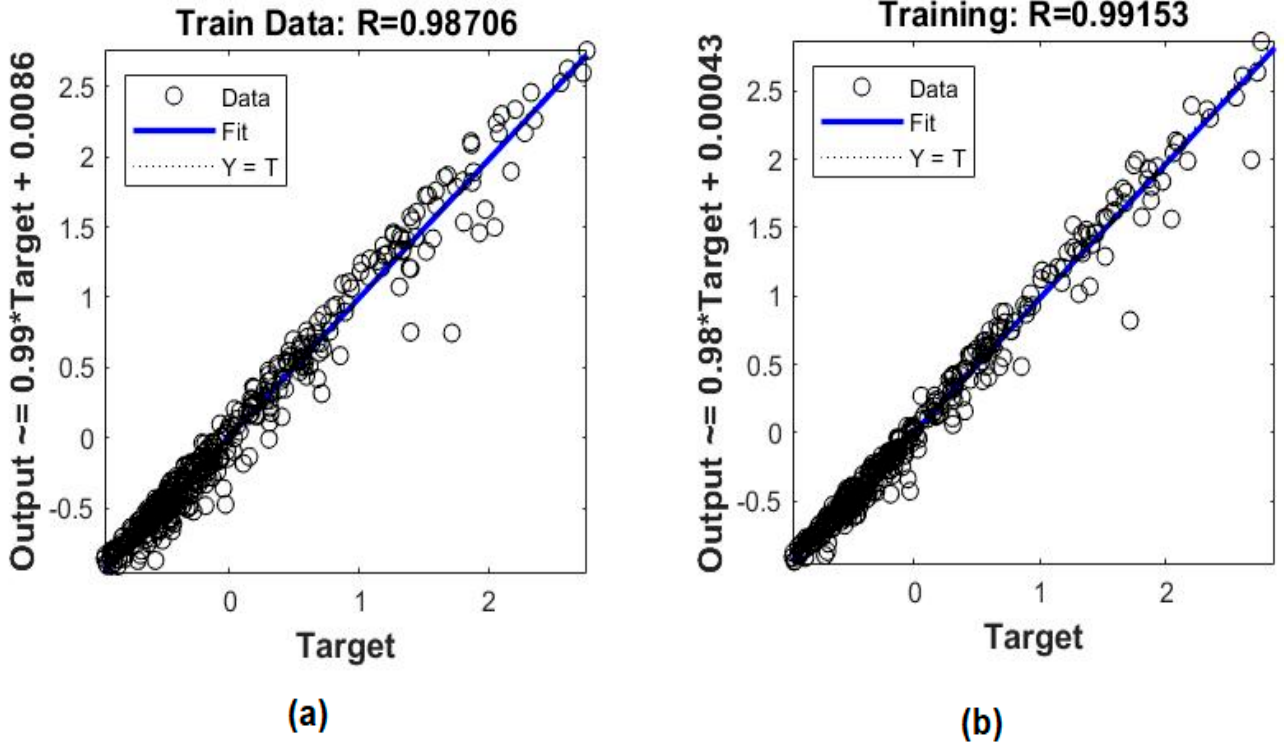
Figure 5. Regression plot for predicting bitcoin prices: ( a ) GRU model and ( b ) MLP model.